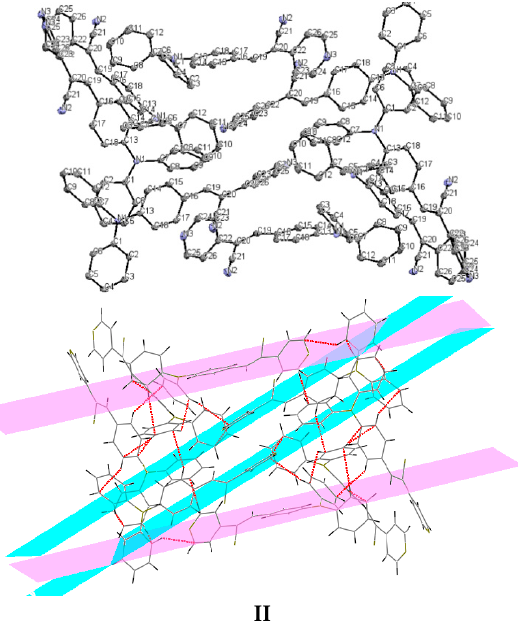
Figure 7. Crystal packing views of I and II with π - π stacking interactions occurring between neighboring aromatic rings.